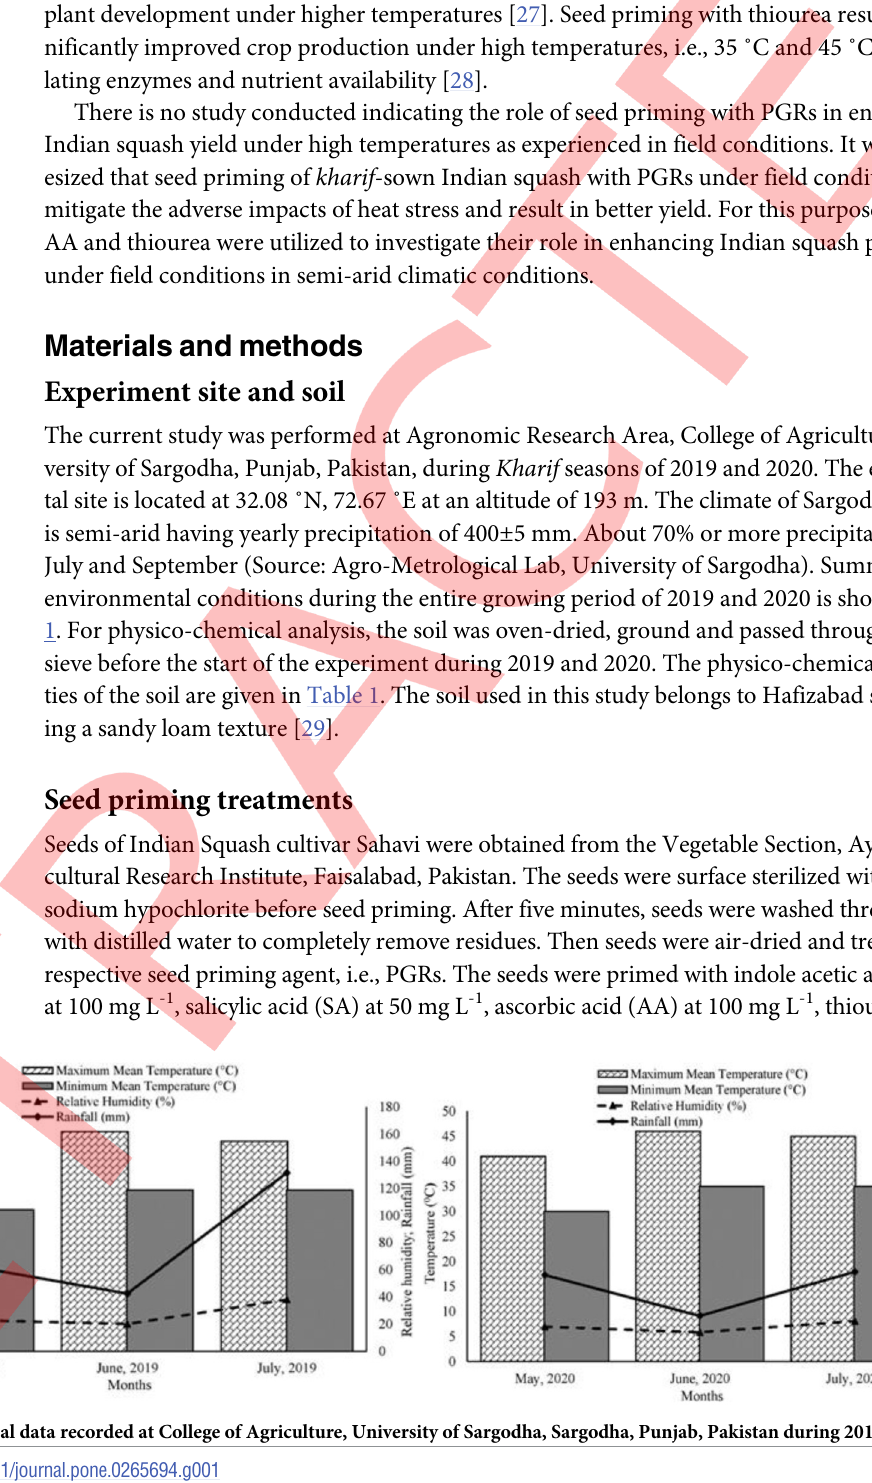
PLOS ONE | https://doi.org/10.1371/journal.pone.0265694 April 14,